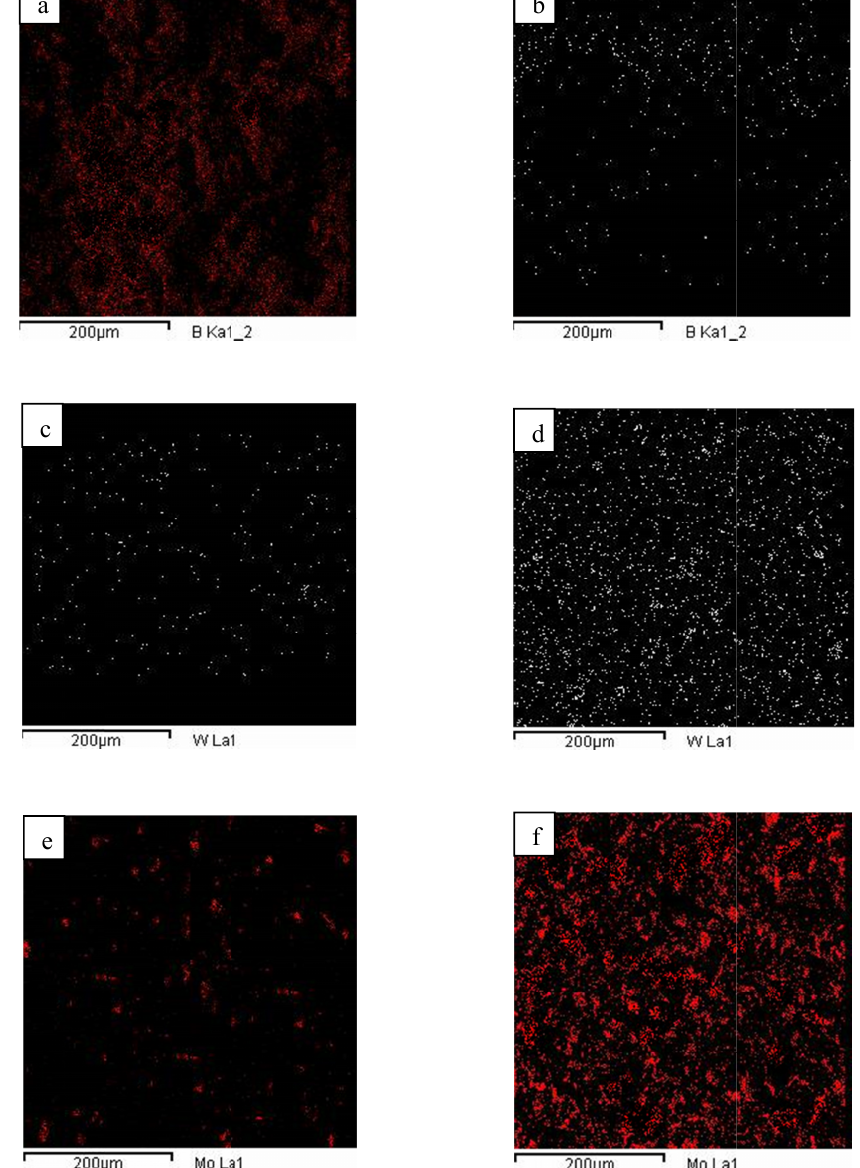
result is give polyethylene